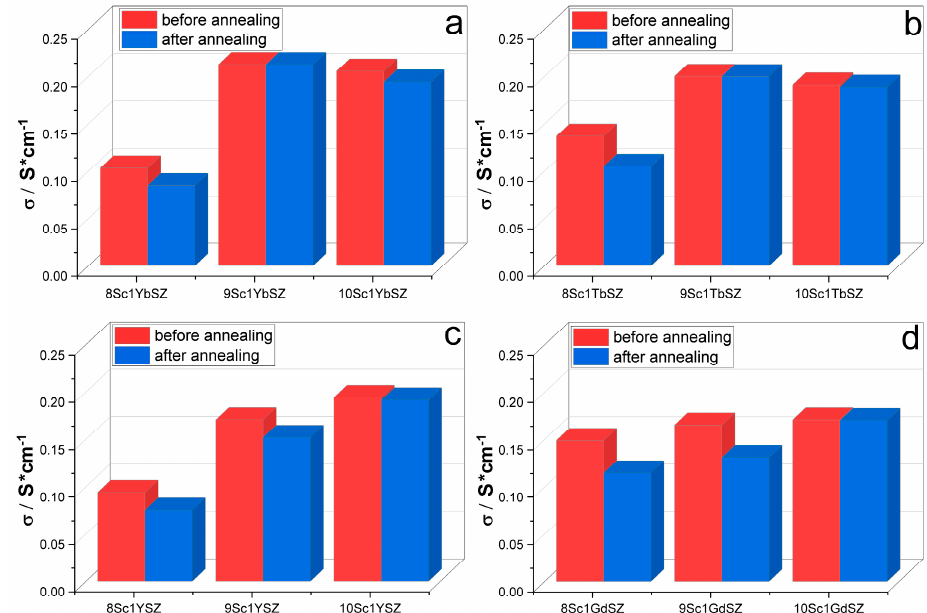
Figure 6. Specificelectricalconductivityofcrystals(ZrO 2 ) 0.99 − x (Sc 2 O 3 ) x (Yb 2 O 3 ) 0.01 ( a );(ZrO 2 ) 0.99 − x (Sc 2 O 3 ) x (Tb 2 O 3 ) 0.01 Figure 6. Specific electrical conductivity of crystals (ZrO 2 ) 0.99- х (Sc 2 O 3 ) х (Yb 2 O 3 ) 0.01 ( а ); (ZrO 2 ) 0.99- ( b );(ZrO 2 ) 0.99 − x (Sc 2 O 3 ) x (Y 2 O 3 ) 0.01 ( c );(ZrO 2 ) 0.99 − x (Sc 2 O 3 ) x (Gd 2 O 3 ) 0.01 ( d х (Sc 2 O 3 ) х ( Т b 2 O 3 ) 0.01 ( b ); (ZrO 2 ) 0.99- х (Sc 2 O 3 ) х (Y 2 O 3 ) 0.01 ( c ); (ZrO 2 ) 0.99- х (Sc 2 O 3 ) х (Gd 2 O 3 ) 0.01 ( d ).